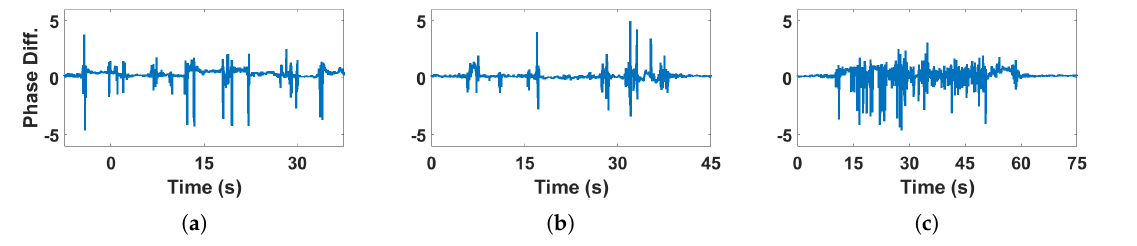
Figure 7. CSI phase difference of human motion activities under LOS condition ( a ) One person, daily activity; ( b ) Two persons, daily activity; ( c ) Two persons, intense